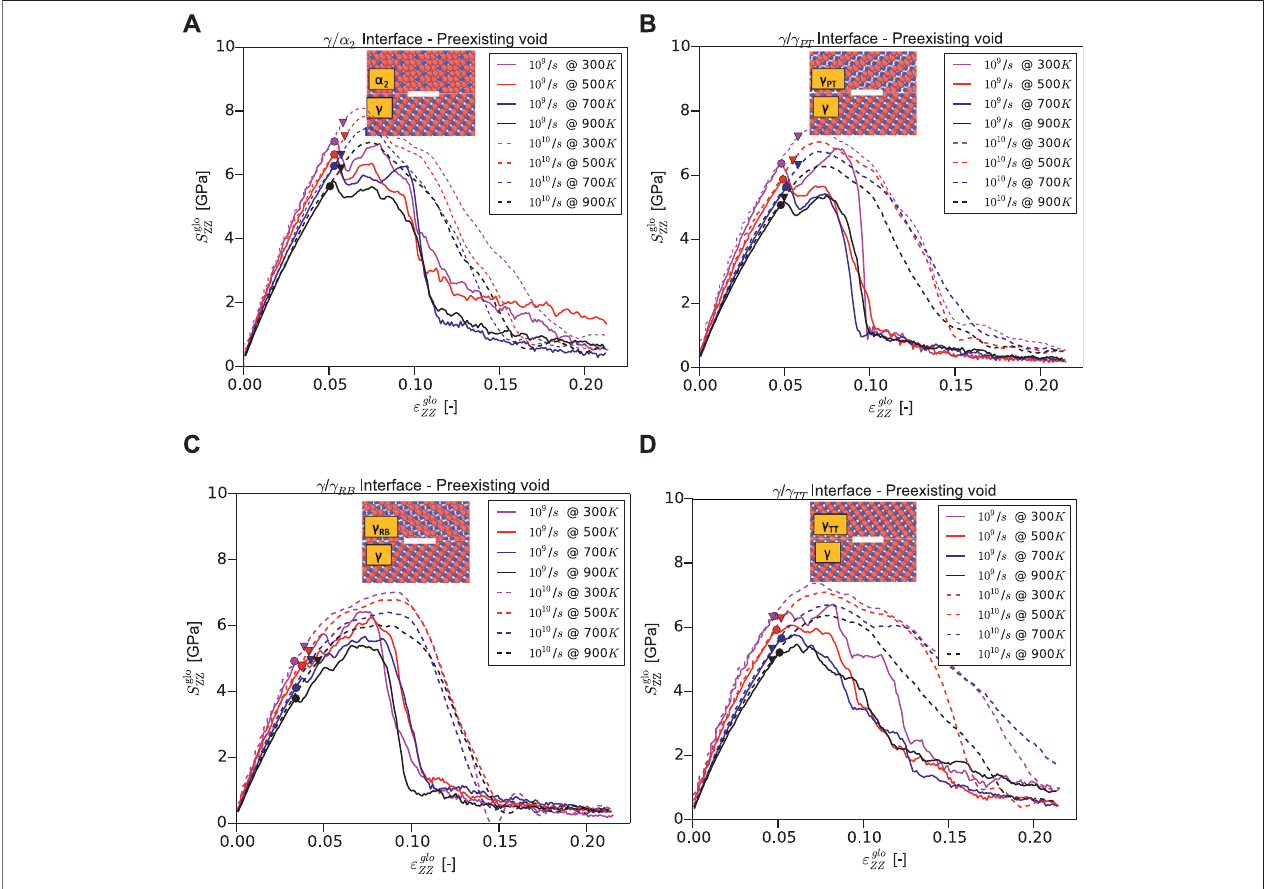
FIGURE 5 | Stress – strain curves under normal loading for Type-2 models (with preexisting void) of (A) c / α 2 , (B) c / c PT , (C) c / c RB , and (D) c / c TT interfaces for different temperatures and strain rates. Here, the inset shows the section of the corresponding interfaces normal to the close-packed direction. The solid circle and triangle markers represent the dislocation nucleation point for the strain rates _ ε glo ZZ (cid:2) 10 9 / s (solid lines, circles) and _ ε glo ZZ (cid:2) 10 10 / s (dashed lines, triangles).